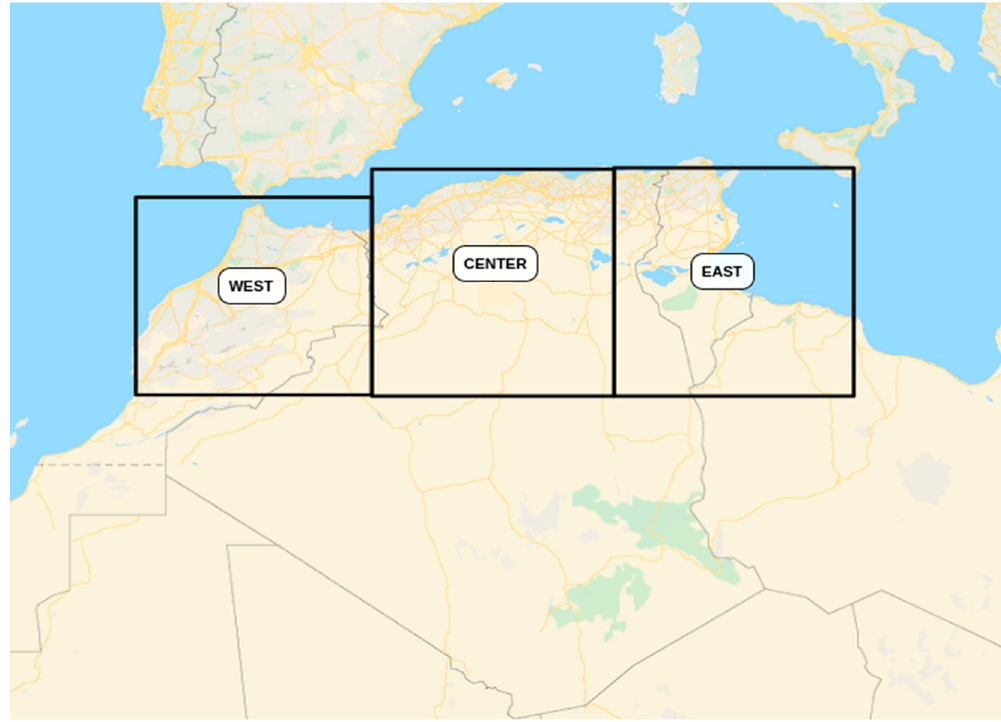
Figure 2. Study area. Precipitation is averaged over solid boxes (western, central, and eastern North Africa) (source: https://www.scribblemaps.com).